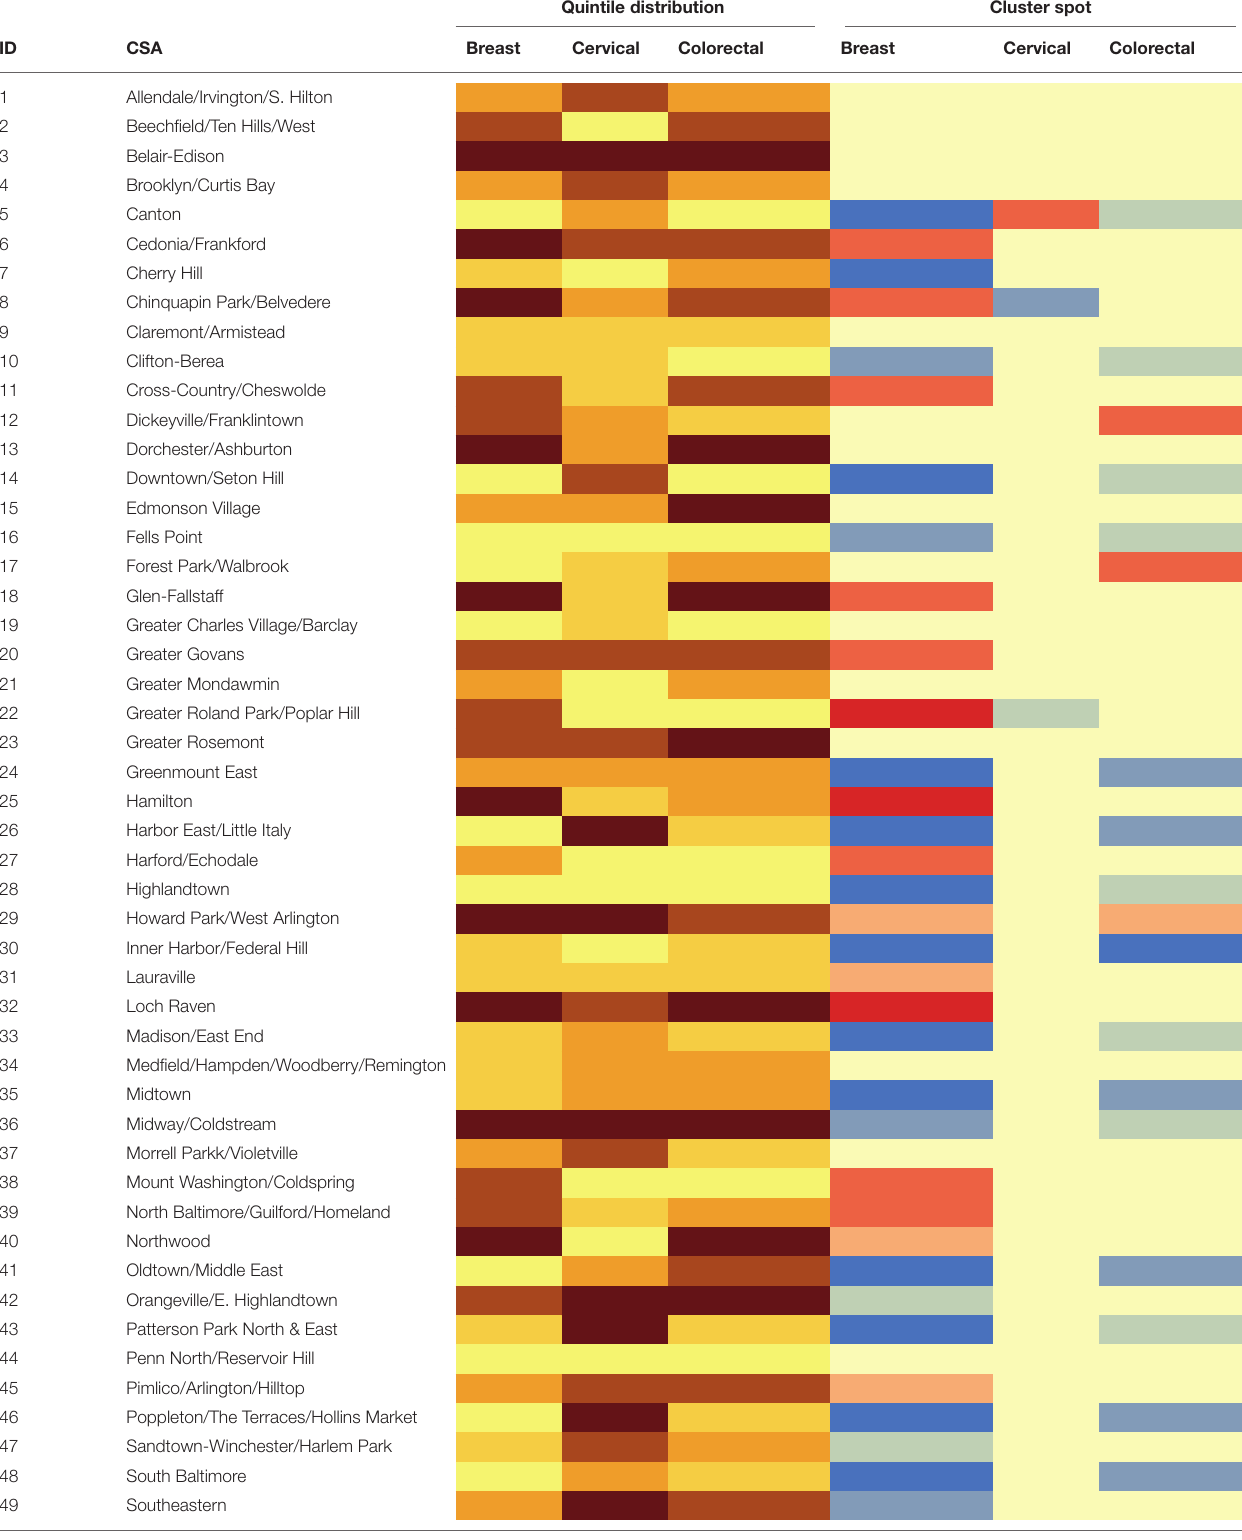
TABLE 2 | Heatmap summarizing the distribution of female cancer incidence (quintiles) and hot/cold spatial clusters by CSA for Baltimore City, 2000–2010. Quintile distribution Cluster spot Breast Cervical Colorectal Breast Cervical